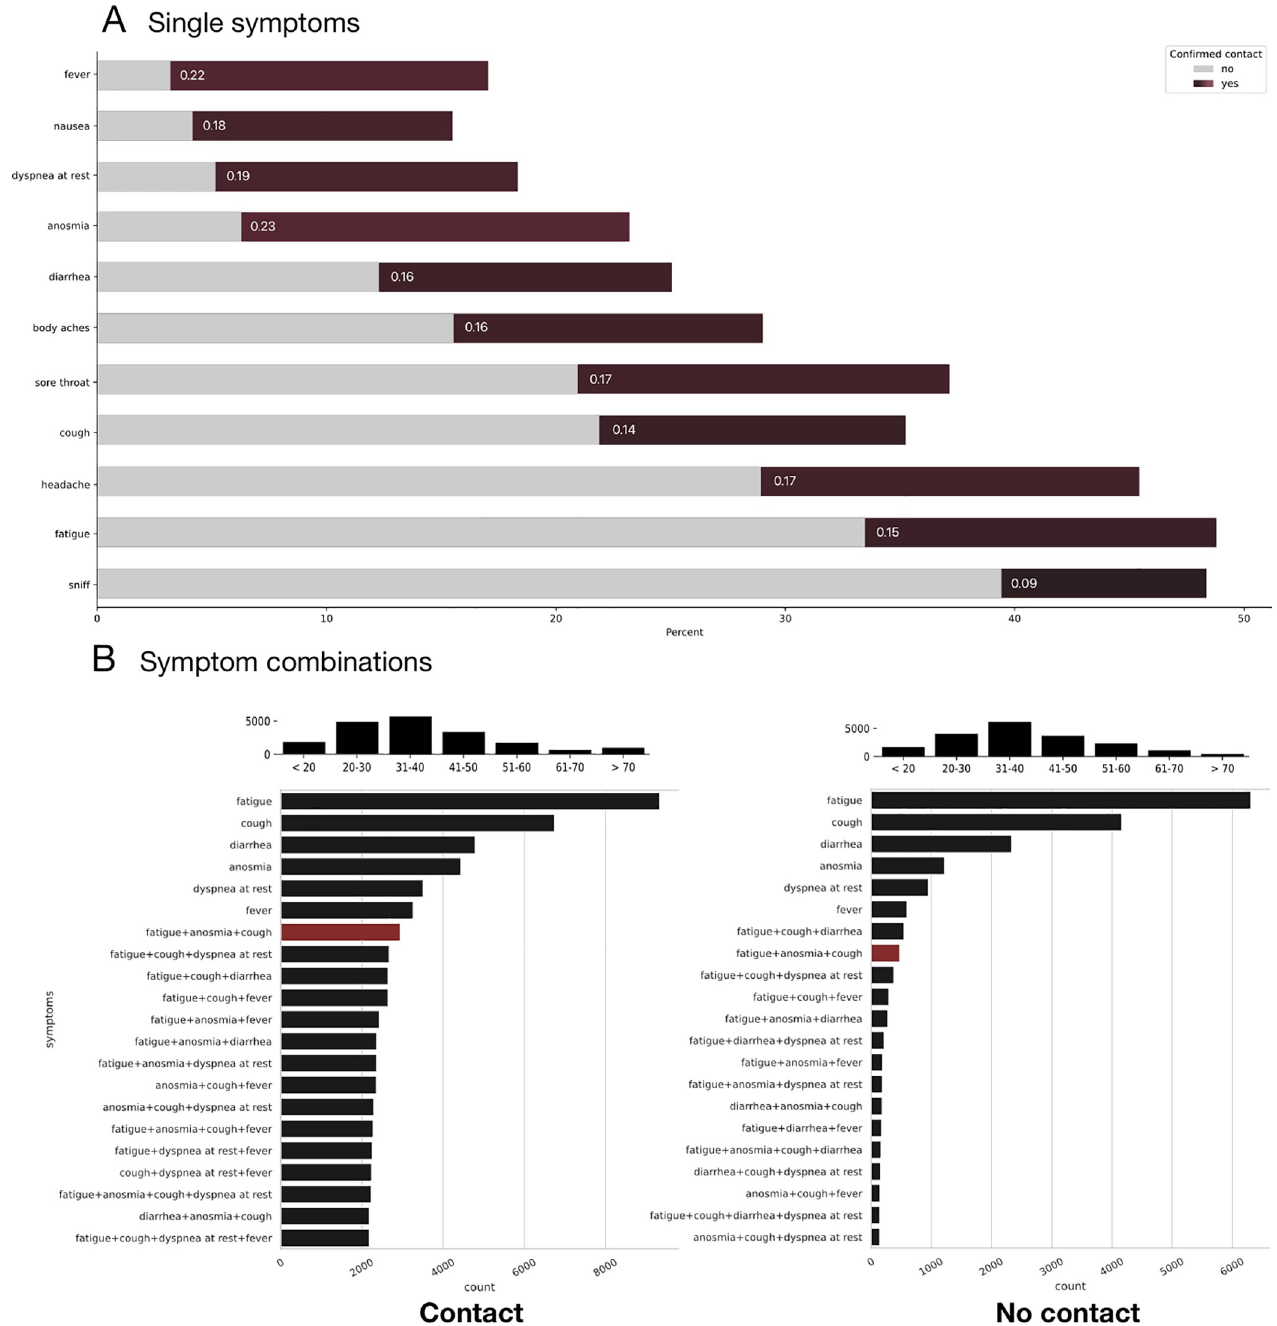
Fig 1. Comparison of symptom distribution between patients with and without confirmed contact. A) Single symptoms : Color coded Cramer’s V correlation of symptoms with the confirmed contact variable (dark red tones) & symptom frequency count in percent of positive statements broken down by groups with and without confirmed contact. Anosmia seems to be the strongest predictor followed by fever and dyspnea at rest. On the contrary, the least single important symptoms are sniff, fatigue and cough by itself. B) Complex symptoms : Symptom frequency count (total) with combinations. The symptom combination fatigue, anosmia and cough has been highlighted in red to illustrate the shift of importance between the two groups. The age distribution of the two groups is depicted in each case above graph B. A random sample of 19128 was taken from the population without confirmed contact for comparison. The percentage of positive cases in the total number of participants without contact was 6 � 24% whereas the percentage of positive cases in the group with confirmed contact was 23 � 21%.